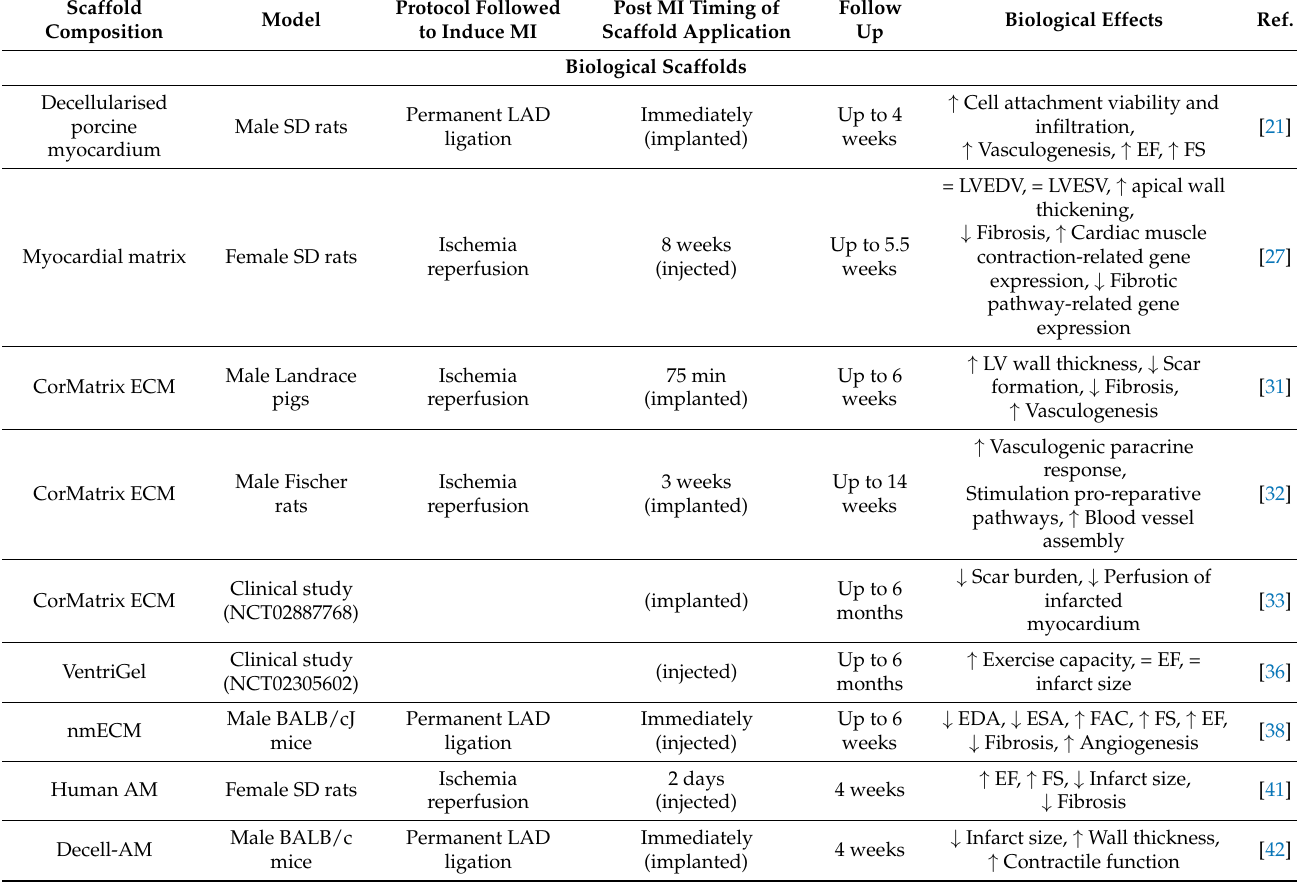
Follow Biological Effects Ref. Up